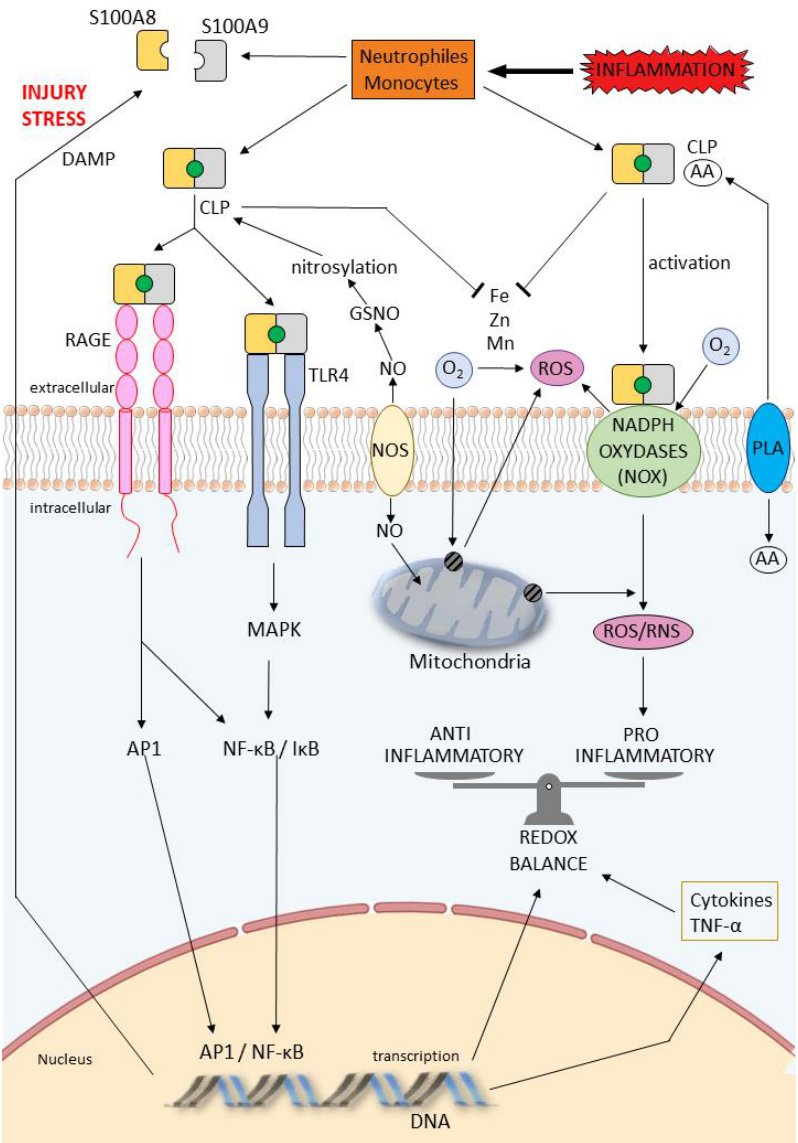
Figure 2. Signaling pathways of RAGE and TLR4 and schematic diagram of the contributory ROS and RNS induced by S100A8/A9 proteins, expressed and released in cells (neutrophils and monocytes) during injury stress. Both RAGE and TLR4 can trigger signaling events that activate the formation of endogenous complex, resulting in AP1/MAPK activation, NF- κ B nuclear translocation and transcrip- tion of cytokines. Phospholipases A2 (PLA) catalyzes the hydrolysis of membrane phospholipids to liberate arachidonic acid (AA). In myeloid cells, intracellular CLP may transfer AA to the NADPH oxidase complex, inducing oxidative bursts that further enlarge inflammation. CLP binds various transition metal ions such as Zn(II), Cu(II) and Fe(II) with strong affinity, ultimately leading to reduction in ROS production in the mitochondria and through the oxidases. S100A8, S100A9 proteins and CLP are S-nitrosylated by NO donors including S-nitrosoglutathione (GSNO). NO is generated by endothelial NOS; AA: arachidonic acid; AP1: activator protein 1; CBP: calcium-binding proteins; CLP: calprotectin; DAMP: damage associated molecular pattern; MAPK: mitogen activated protein kinase; NADPH: nicotinamide dinucleotide phosphate; NF- κ B: nuclear factor kappa B; NO: nitric oxide; NOS: nitric oxide synthase; NOX: nicotinamide dinucleotide phosphate (NADPH) oxidase; RAGE: receptor for advanced glycation end products; RNS: reactive nitrogen species; ROS: reactive oxygen species; TLR: toll-like receptor; TNF- α : tumor necrosis factor alpha; TRP: transient receptor potential; VCAM-1: vascular cell adhesion molecule